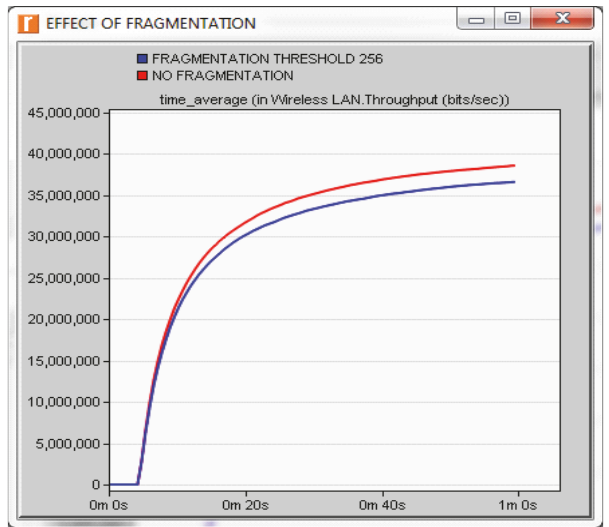
Figure 13: WLAN throughput with and without